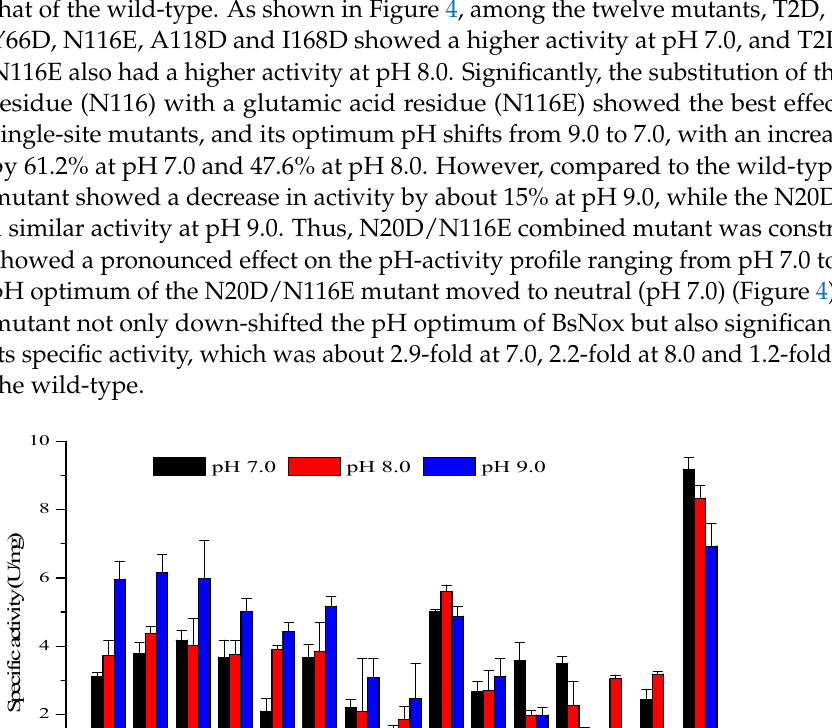
Figure 4. Effects of pH on the specific activity of BsNox and its variants.